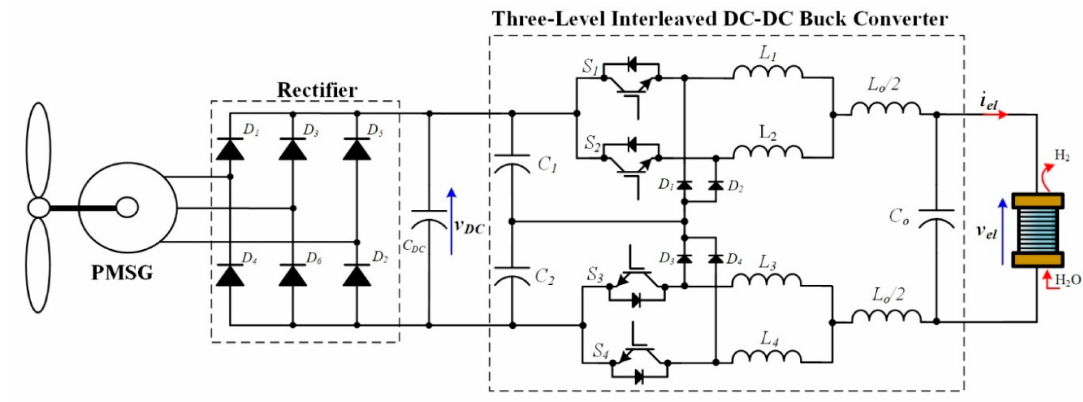
Figure 17. Hydrogen production pathway based on a wind energy conversion system and a three-level interleaved DC-DC buck